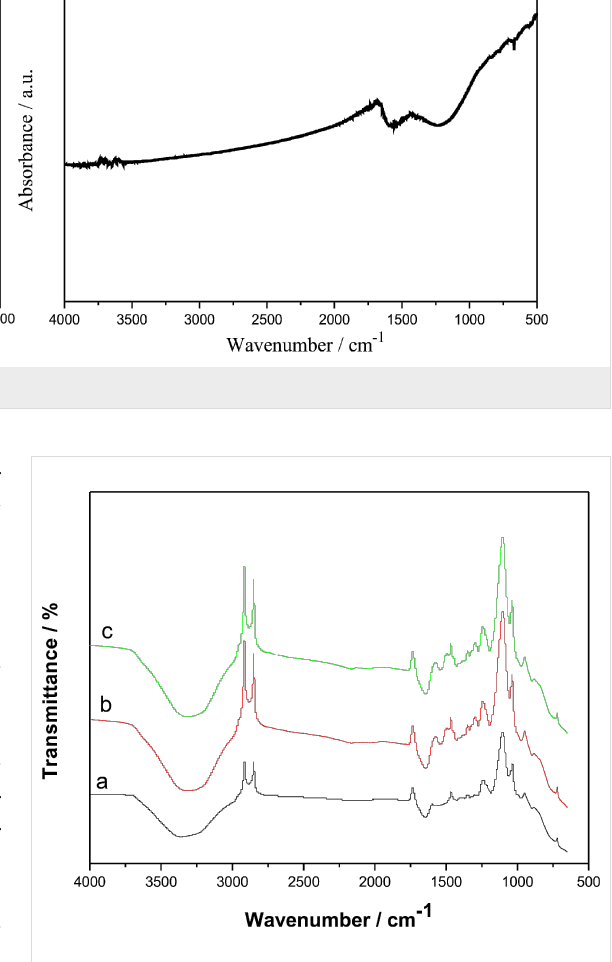
Figure 3: FTIR spectra of laccase (a), laccase – Nafion (b), and laccase – Nafion – ECNFs (c) thin films, respectively.